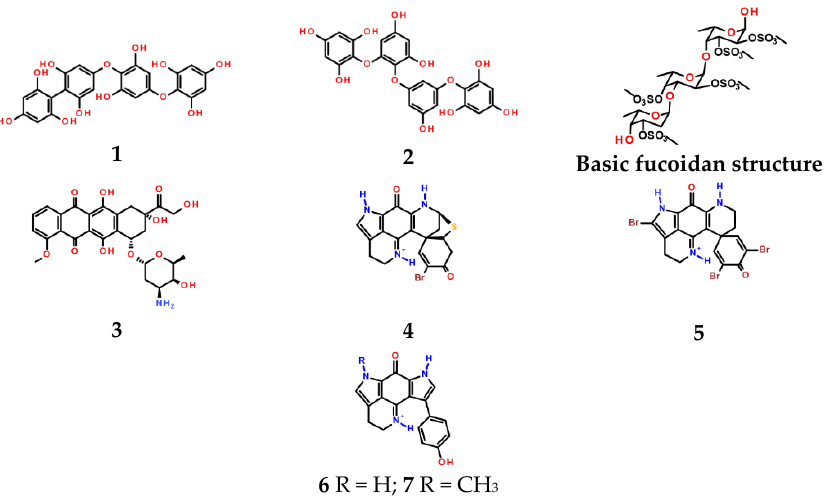
Figure 1. Structures of the compounds referred to or used in this study: fucodiphlorethol ( 1 ), tetraphlorethol ( 2 ), Doxorubicin ( 3 ), Discorhabdin A ( 4 ), 14-bromodiscorhabdin C ( 5 ), Tsitsikammamine A ( 6 ) and Tsitsikammamine B ( 7 ).